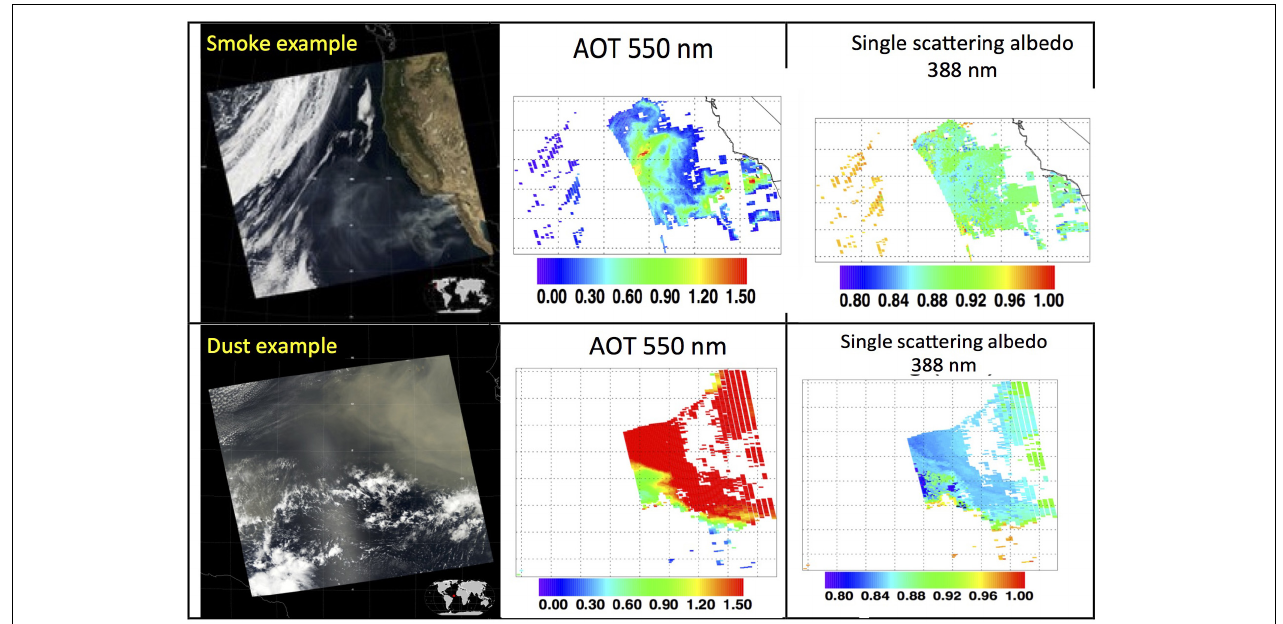
FIGURE 3 | Examples of the proto-type OCI algorithm described in the text applied to custom-built collocated MODIS-OMI granules where the OMI reflectances are mapped to the MODIS granule at the MODIS spatial resolution, although the OMI reflectances maintain their original geometric meta data. The (left) column shows the true color MODIS granules. (Center) Shows the standard MODIS AOD at 550 nm retrievals and the (right) column shows the resulting single scattering albedo at 388 nm using the OMI UV reflectances. (Top) Row is for a smoke case over the ocean (23 October 2007, 21:40 UTC). (Bottom) Row is for a dust case over ocean (13 March 2006, 15:25